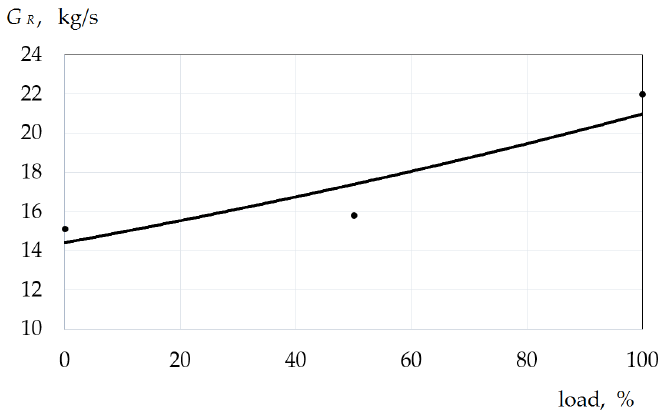
Figure 13. Dependence of air flow rate to registers for all combustion chambers on the load value.